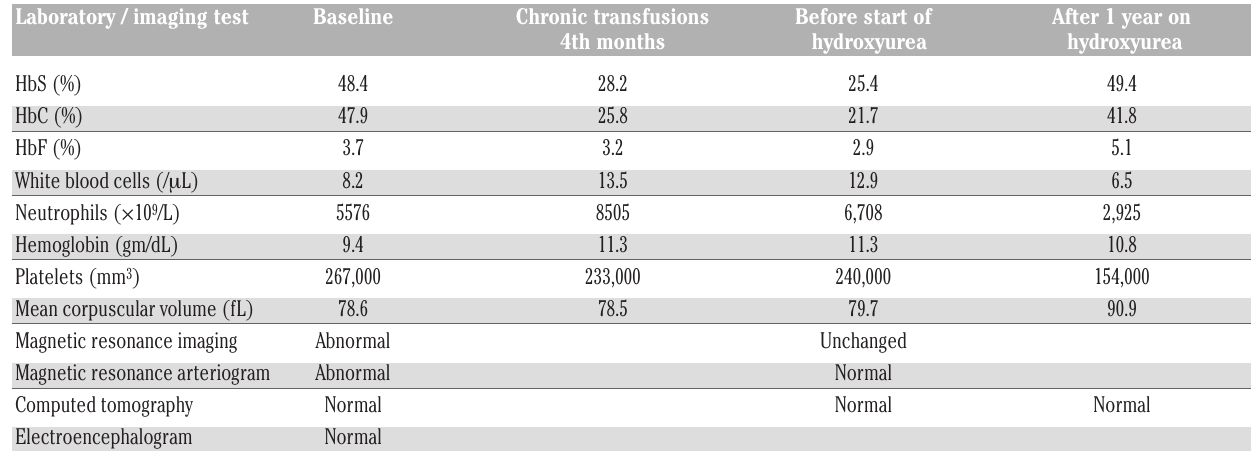
Table 1. Summary of laboratory and imaging tests results.